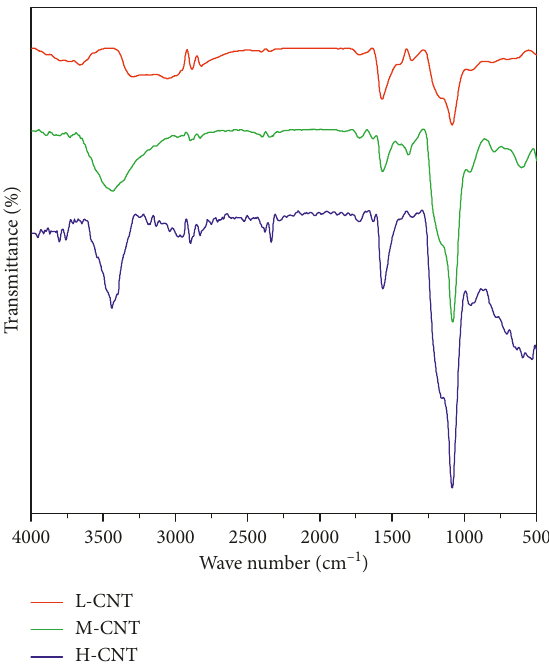
Figure 5: FT-IR spectra for the